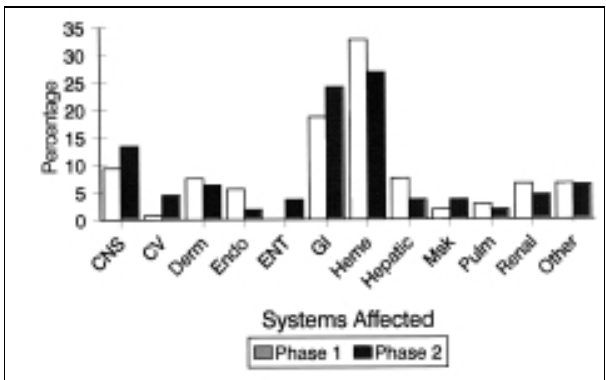
Figure 5) Organ system classification of adverse drug reactions. The percentage breakdown of organ system classification is equal to the frequency of specified organ system involved in adverse drug reactions divided by the total number of systems affected. CNS Central nervous system; CV Cardiovascular; Derm Dermatology; Endo Endocrine; ENT Ears, nose and throat; GI Gastrointestinal; Heme